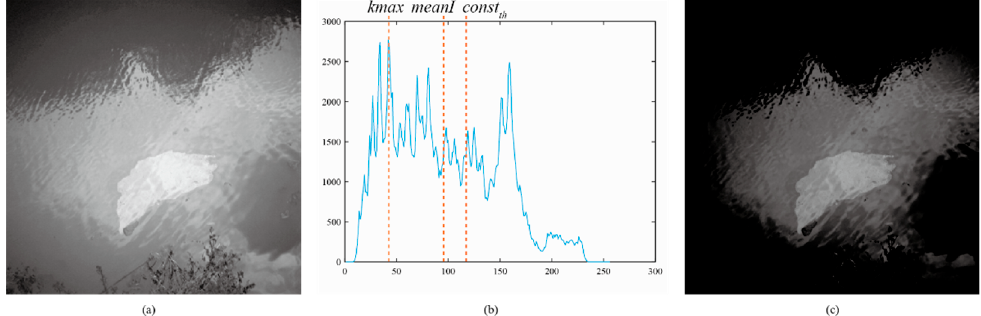
Figure 5. An example of the result of global background suppression (GBS). ( a ) The original image; ( b ) the three candidate threshold values; and ( c ) the global background suppression result.